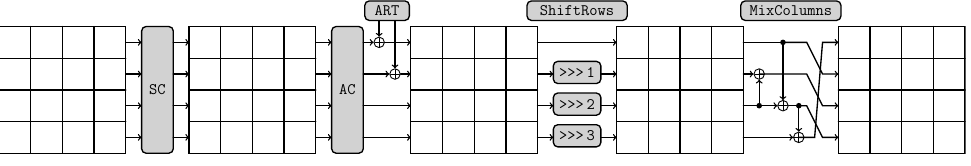
Figure 3: Illustration of one round of SKINNY